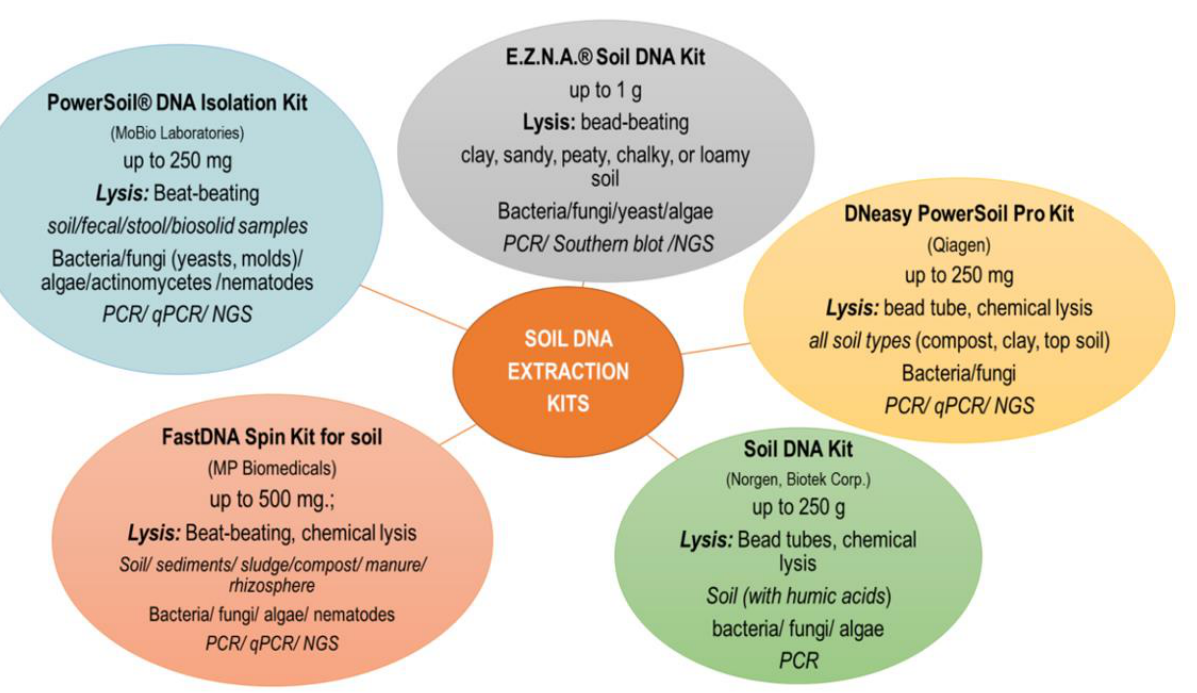
Figure 1. The most popular commercial DNA extraction kits used in the analysis of soil genetic diversity. The sample size, material type, lysis strategy, targeting microorganism and downstream application recommended by the manufacturers were